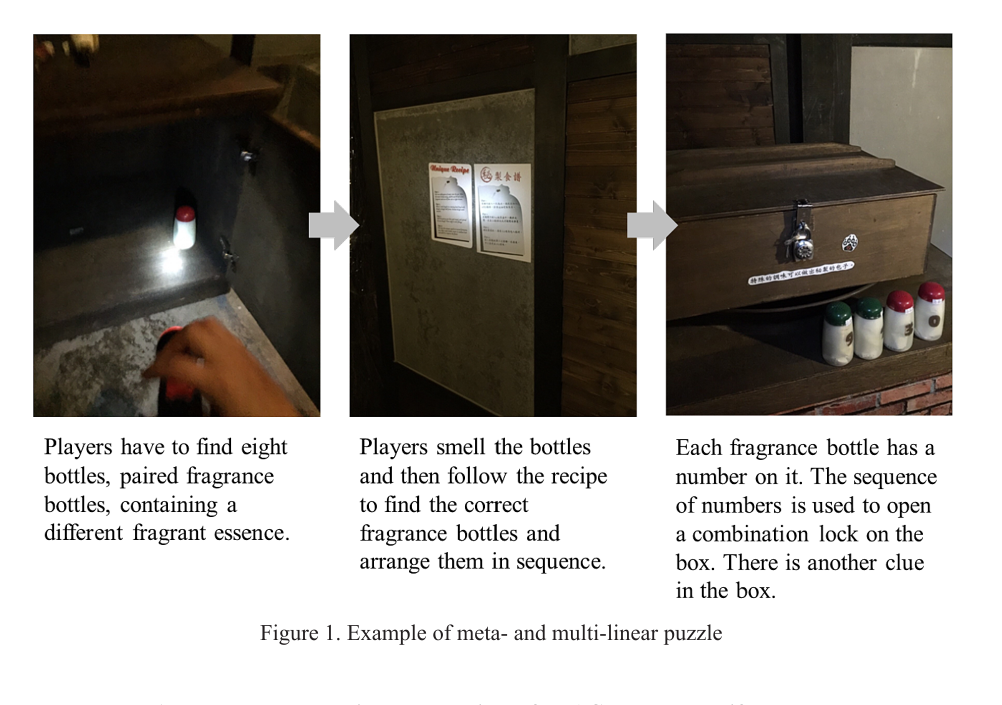
Table 1. The themes and suitable team sizes of PEACH FUN real-life escape games Theme